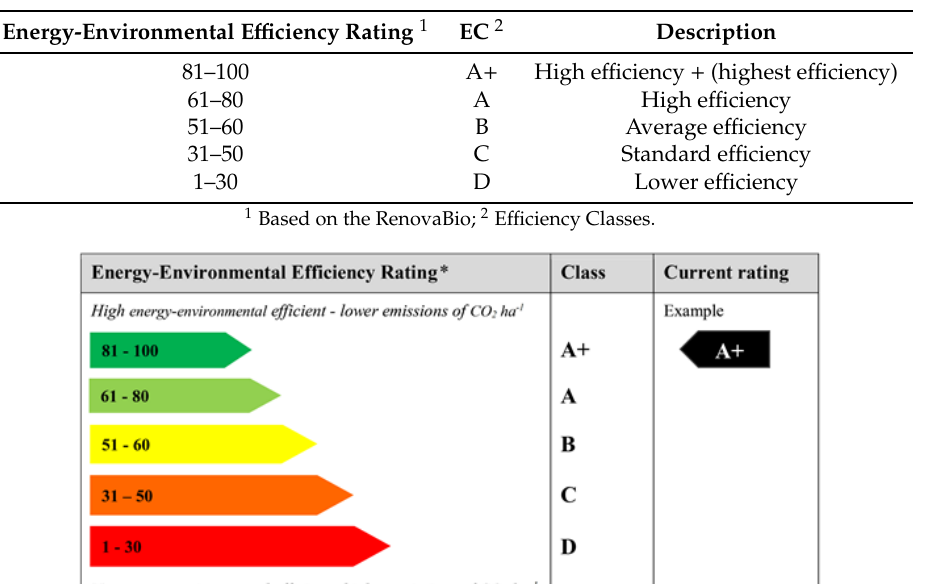
Table 1. Parameters of the level of the Energy-Environmental E ffi ciency Rating.